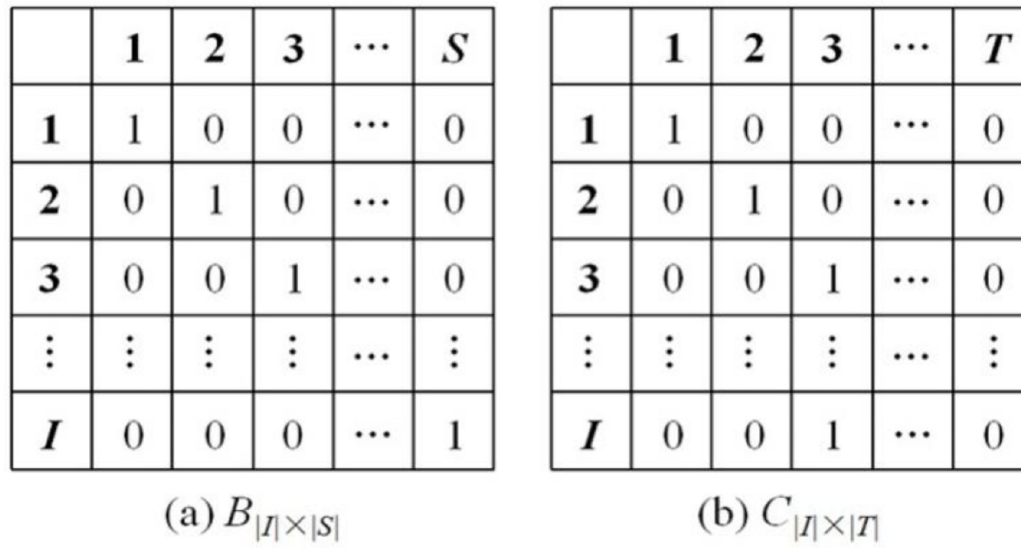
Fig 3. An example of the initial